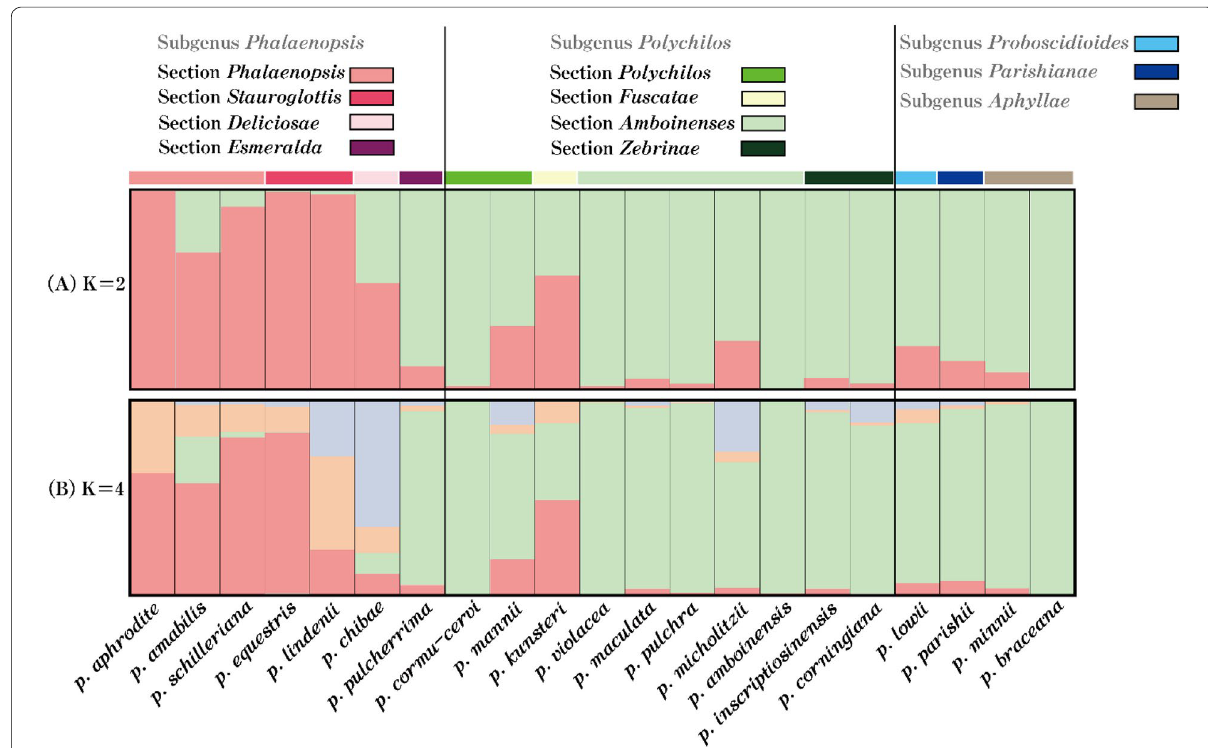
Fig. 1 Genotypic group structure of the genus Phalaenopsis used in this study in K